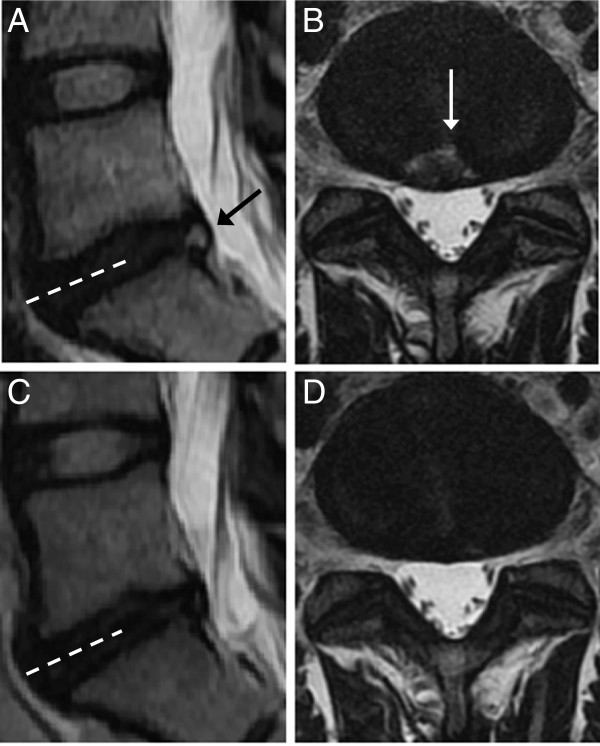
Resolving high intensity zone. Initial (A-B) and follow-up (C-D) T2-weighted magnetic resonance images of one patient. Image plane B is marked on A and image plane D is marked on C (stippled lines). High intensity zone in the L5/S1 disc on initial sagittal (A) and axial (B) images (arrows) is resolved on later sagittal (C) and axial (D) images.